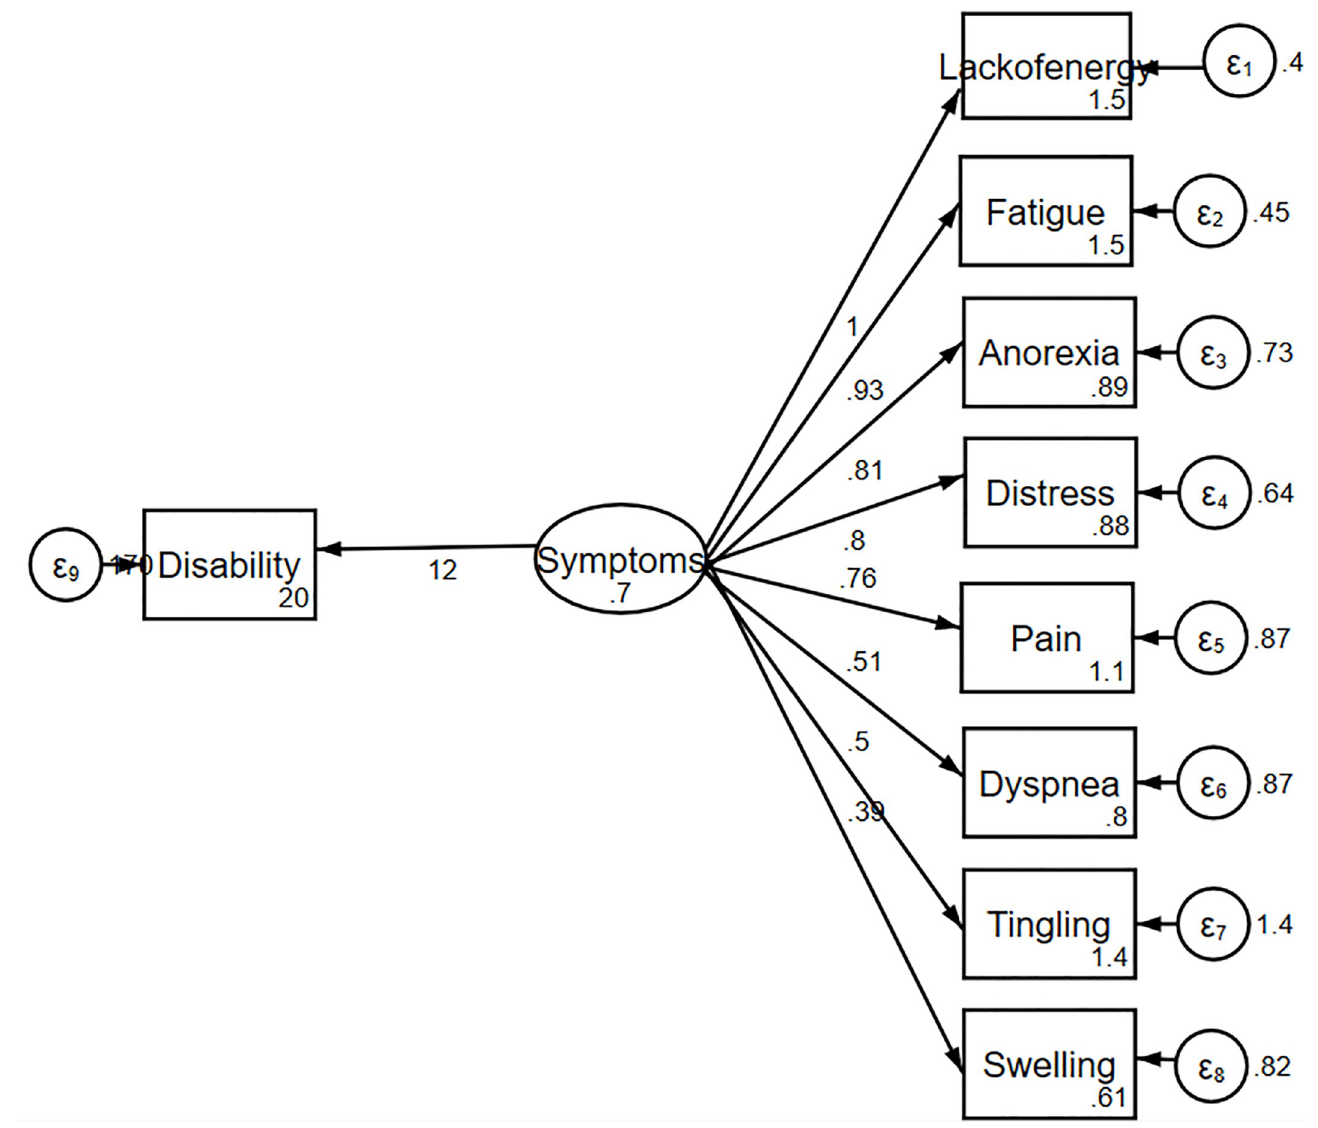
Fig 1. One-factor model of the relationship between symptoms and